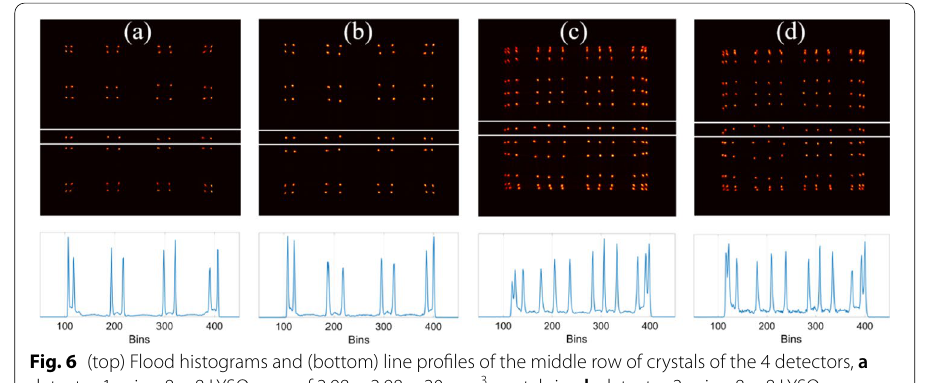
2.98 20 mm 3 crystal size, b detector 2 using 8 × ×